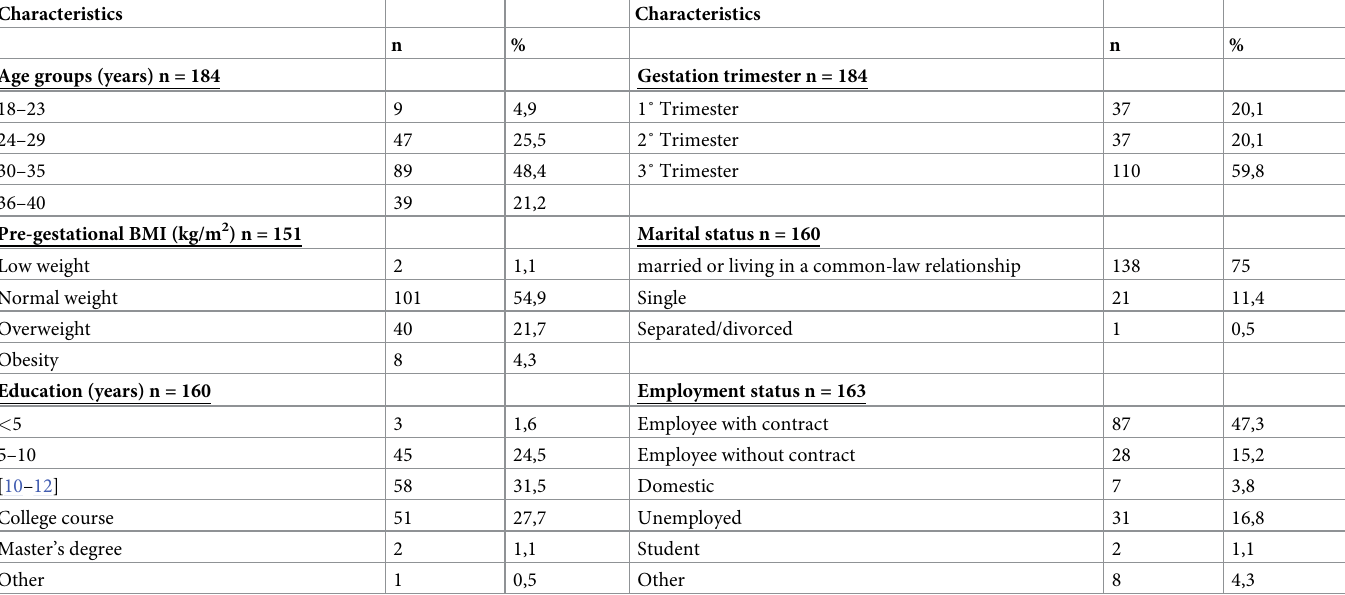
Table 2. Sociodemographic data (n = 184) of sample 1, related to the PPAQ reliability test. Characteristics